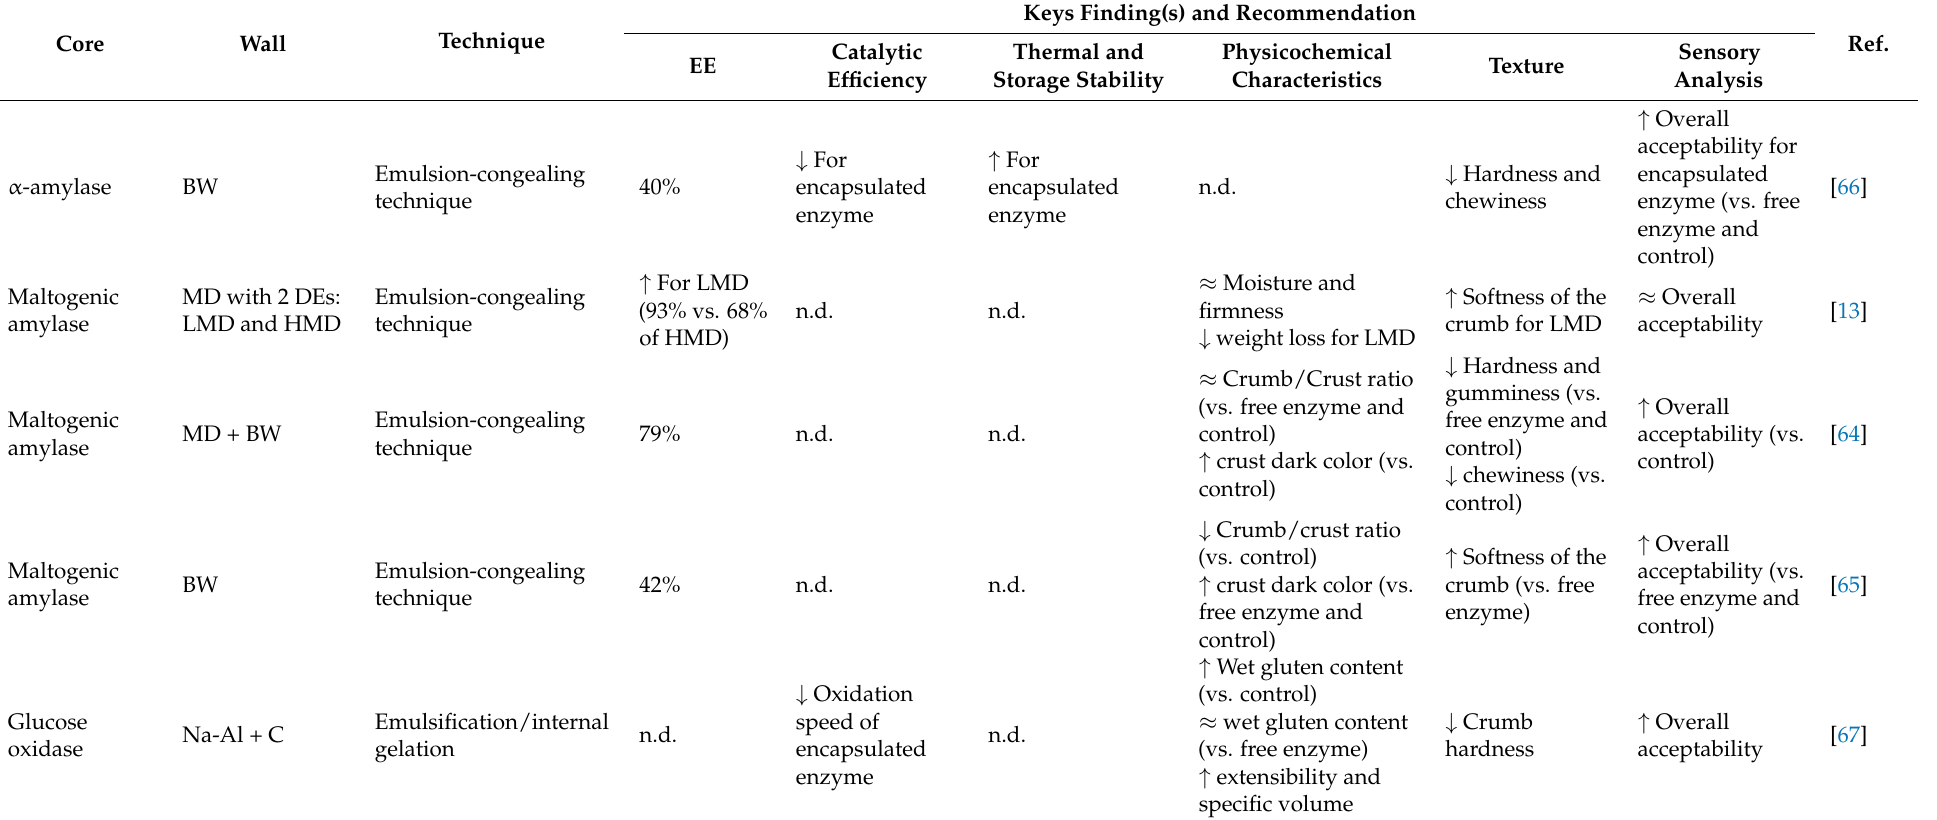
Table 6. Encapsulation of enzymes for bread